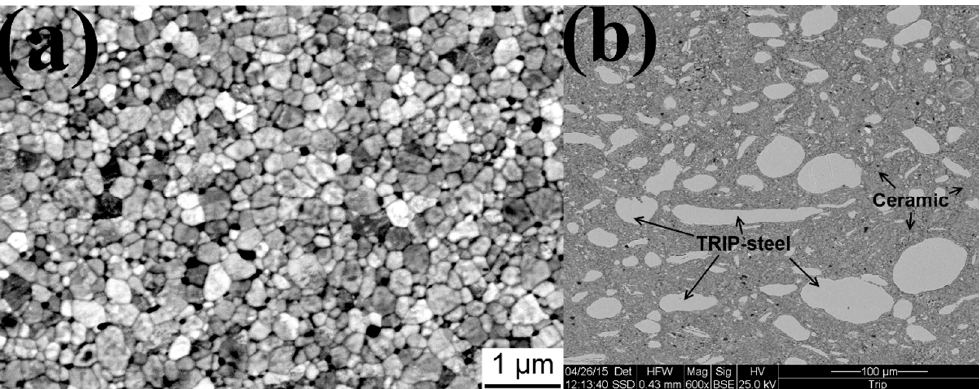
Figure 1. Microstructure of SPS-consolidated specimens: ( a ) (3Y)-TZP; ( b ) composite. Table 1. Properties of the (3Y)-TZP ceramic and composite.